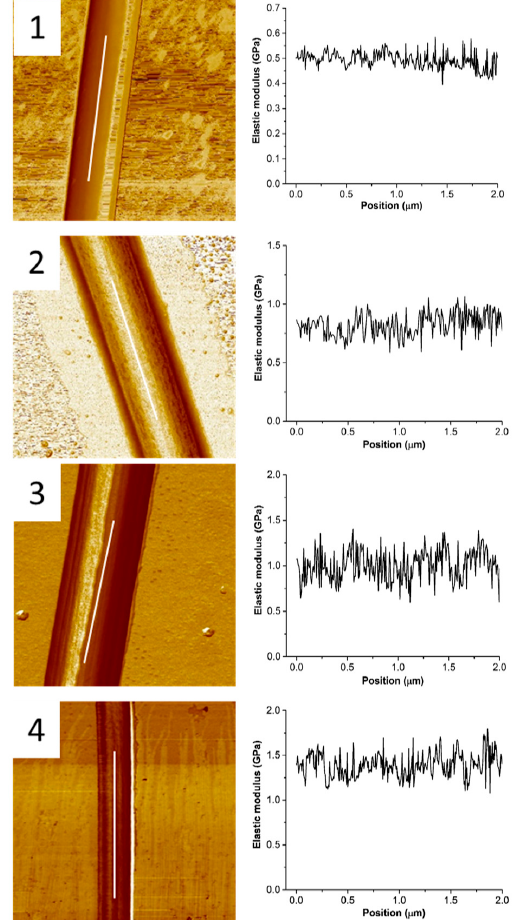
Figure 6. Peak force quantitative nanomechanical (PFQNM) stiffness images (left column) and the Derjaguin–Muller–Toporov (DMT) modulus (right column) of a single Ch / P nanofiber using different ratios of Ch / P (samples 1, 2) and different Mw and DA (samples 3, 4). 2 µm line profile was drawn along the major axes of nanofiber for averaging DMT values; 3 µm × 3 µm scan size. Herein, S1 exhibits a stable young modulus of approximately 500 MPa, however when increasing the content of phospholipid (S2) the modulus was observed to increase to approximately 750 MPa. Such increase in young modulus is related with the increase in the fiber diameter with the